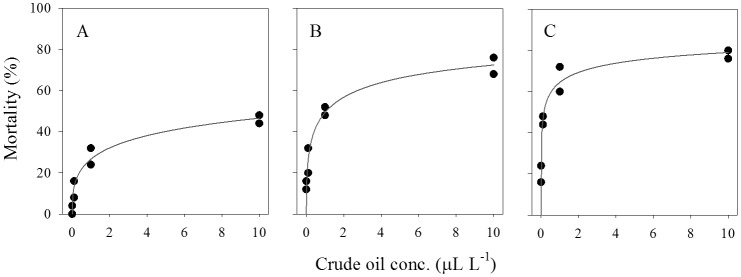
Relationships between mortality (%) of ephyra larvae of the scyphozoan Aurelia aurita and crude oil concentration after 24 (A), 48 (B) and 72 (C) hours of exposure.Regression lines based on Equation (1).